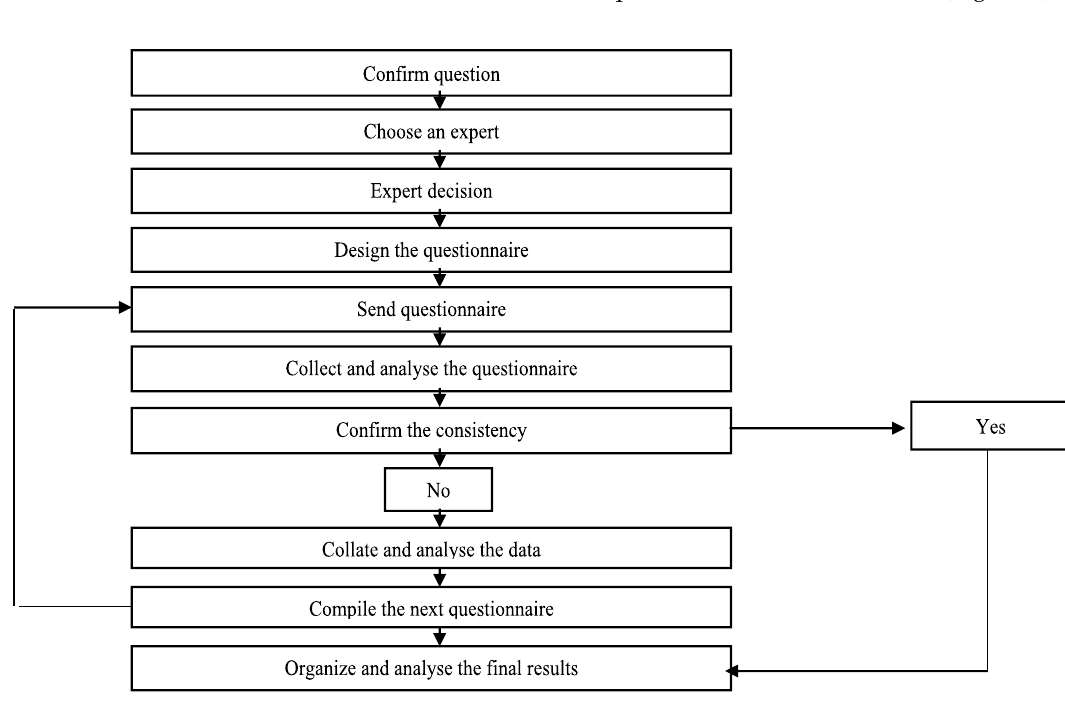
Figure 1. Delphi process.